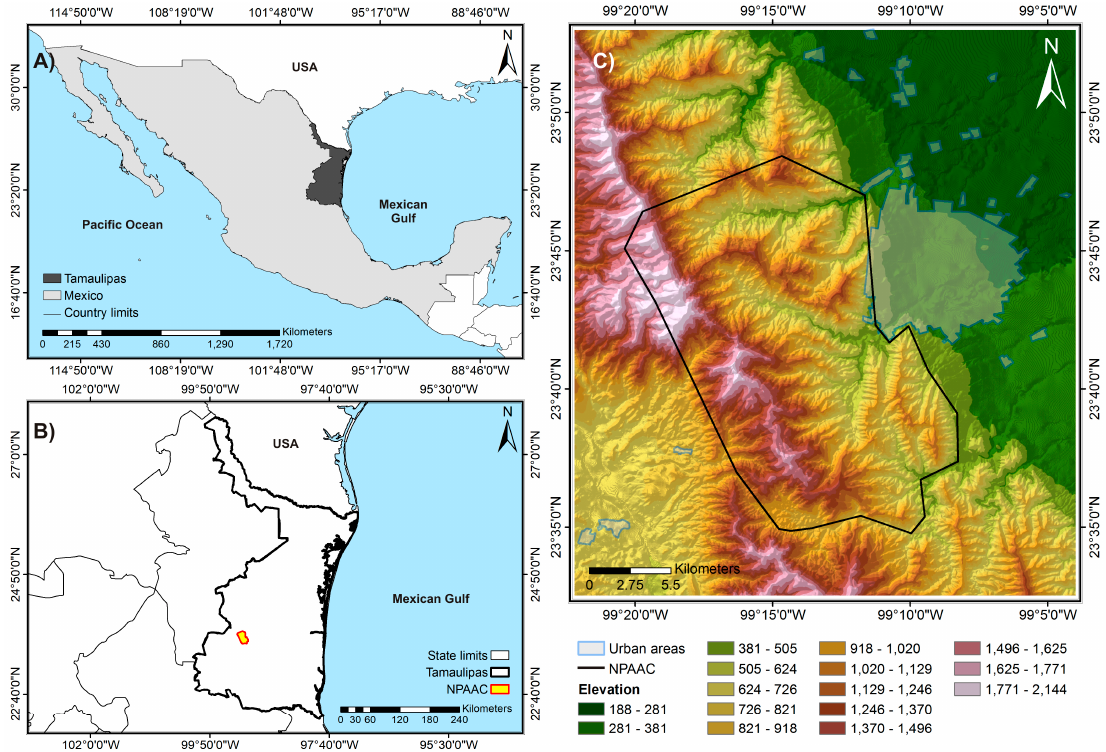
Figure 1. Location of the Natural Protected Area Altas Cumbres (NPAAC). ( A ) Location of Tamaulipas in Northeastern Mexico; ( B ) Geographical position of the NPAAC in the state of Tamaulipas; ( C ) NPAAC elevation range and its adjacent urban areas.